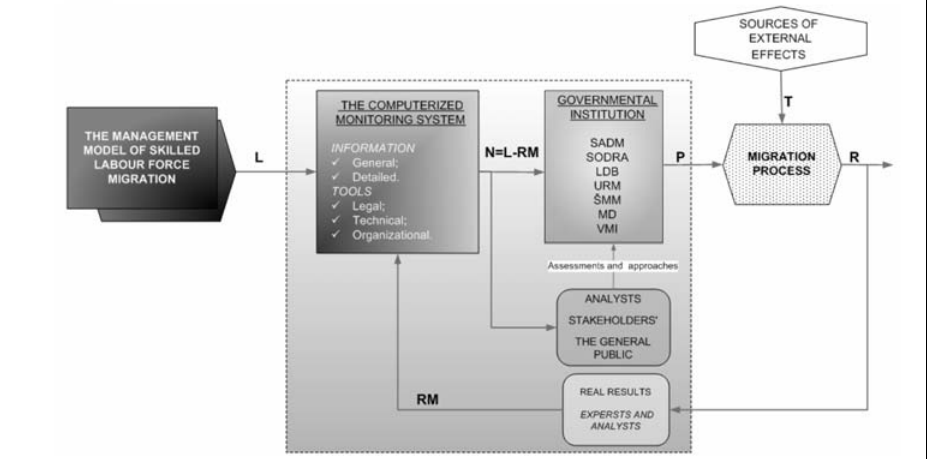
Fig 3. The scheme of